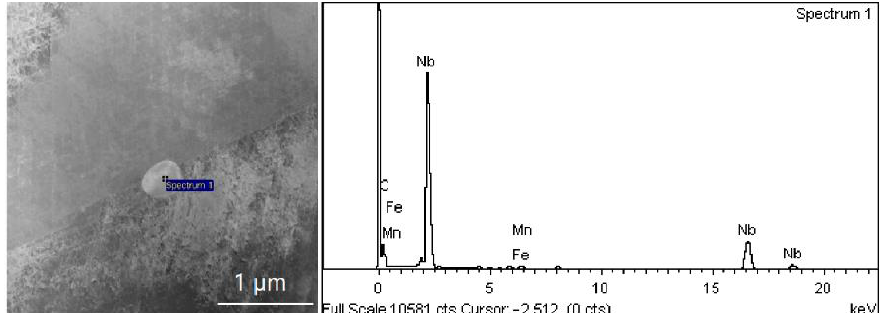
Figure 6. Transmission electron microscopy (TEM) bright-field morphologies and EDS analysis of Fe–28Mn–10Al–C–0.5Nb steel.